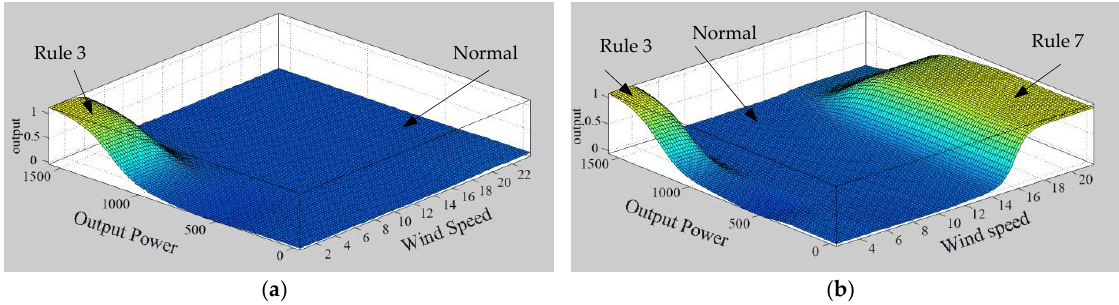
Figure 3. Training results of the models: ( a ) traditional Adaptive Neuro-fuzzy Inference System (ANFIS) model; and ( b ) modified ANFIS model.